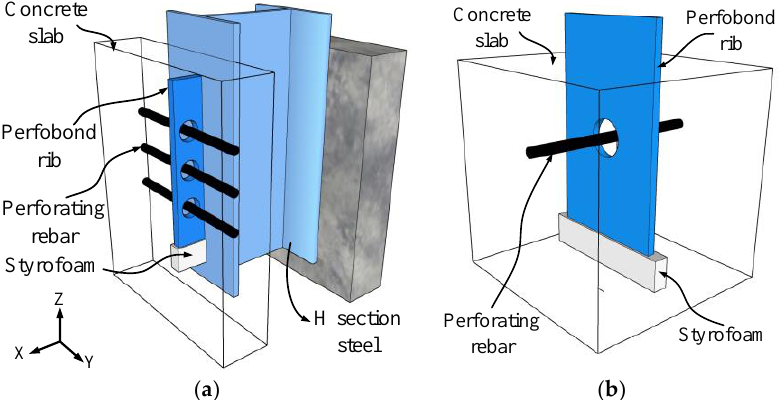
Figure 1. Typical perfobond connector specimens: ( a ) Superposed perfobond connector; ( b ) Inserted perfobond connector.